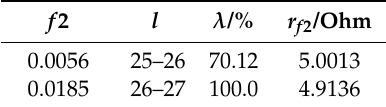
Table 13. Optimal solutions of f 2 when fault occurred at each branch in set 2 for Case 5.